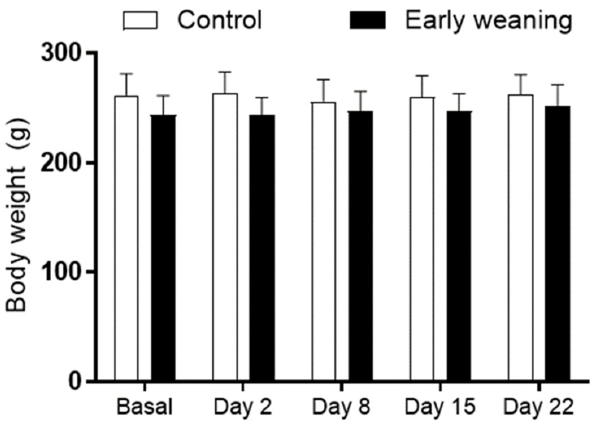
Figure 1. Effect of Early Weaning associated with chronic stress on body weight of adult rats. The animals’ body weight was obtained at ages 166–168 days (basal analysis) and on days 2 (169–171 days of age), 8 (175–177 days of age), 15 (182–184 days of age), and 22 (188–190 days of age) of alimentary stress. Two ‐ way ANOVA and Bonferroni’s post ‐ hoc test n = 8. Data expressed as mean ± SD.